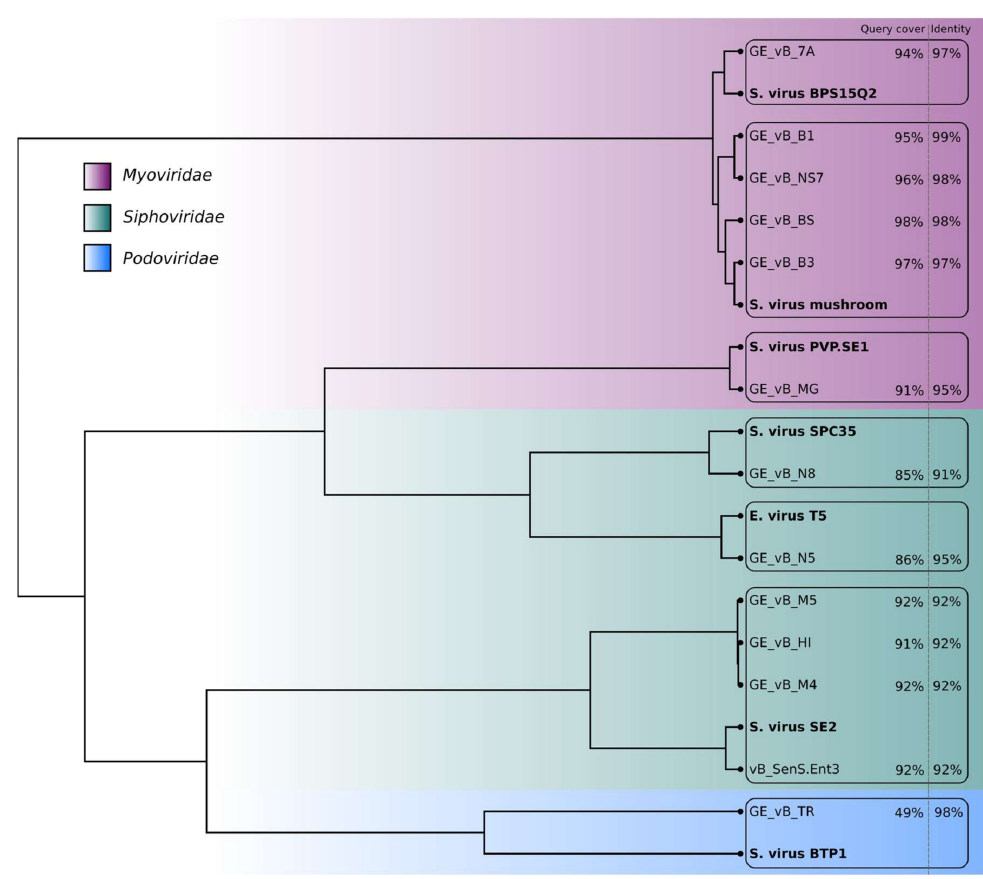
Figure 1. Clustering tree based on the genomic distance matrix generated for the Salmonella phages from the Eliava R&D collection and their closest matches (in bold) in the NCBI database. No genome maps were obtained for phages GE_vB_N3 (Siphovirus) and GE_vB_M1